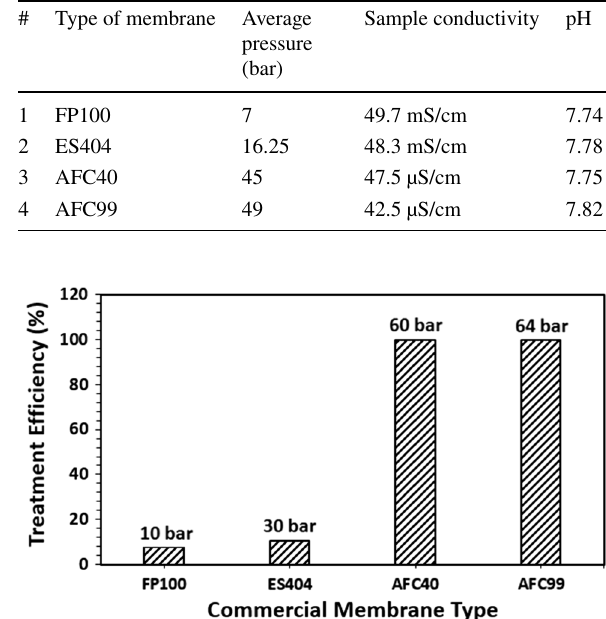
Table 10 Characteristics of the water product for the four commercial membranes at their averaged pressure values